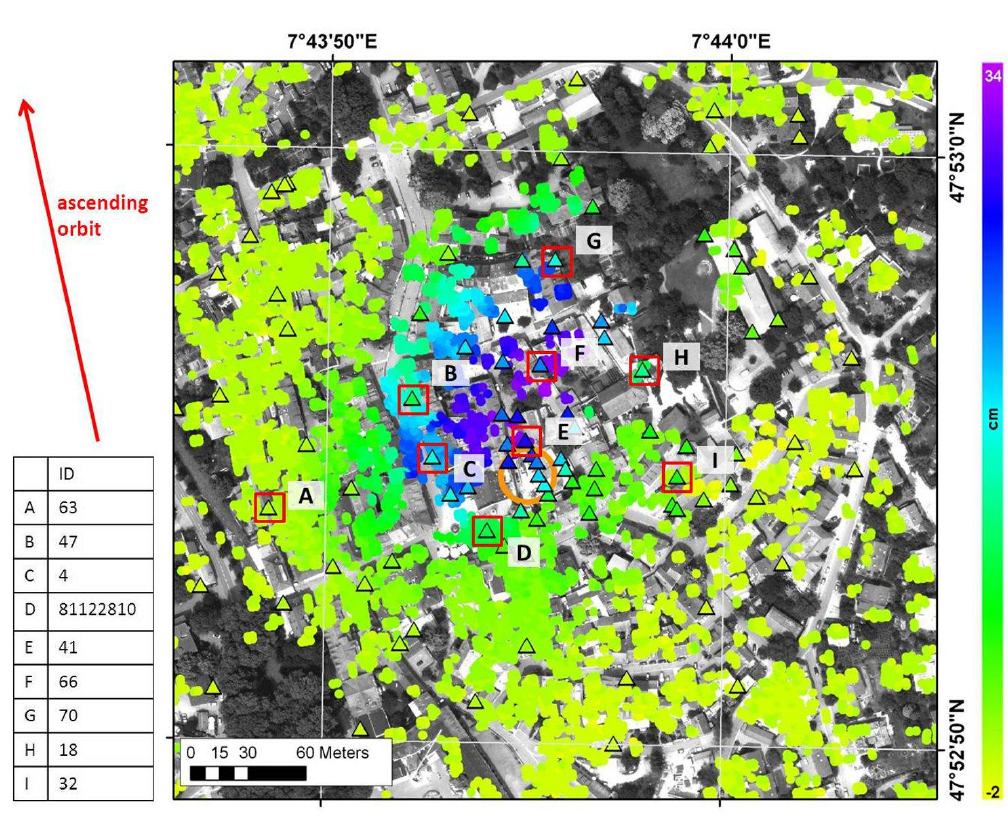
Figure 9. The cumulative LOS uplift pattern based on the SBAS processing (22 July 2008–22 May 2011) and the vertical cumulative motion of the leveling survey points (19 August 2008–23 May 2011). The SDFP pixels are indicated by circles and the leveling survey points are indicated by triangles. The points selected for the time series investigation (Figure 10) are highlighted with a red outline and labeled with a capital letter for easier connection with Figure 10. The official survey point IDs are given on the left side of the figure for reconstruction purposes. An orange circle marks the drilling